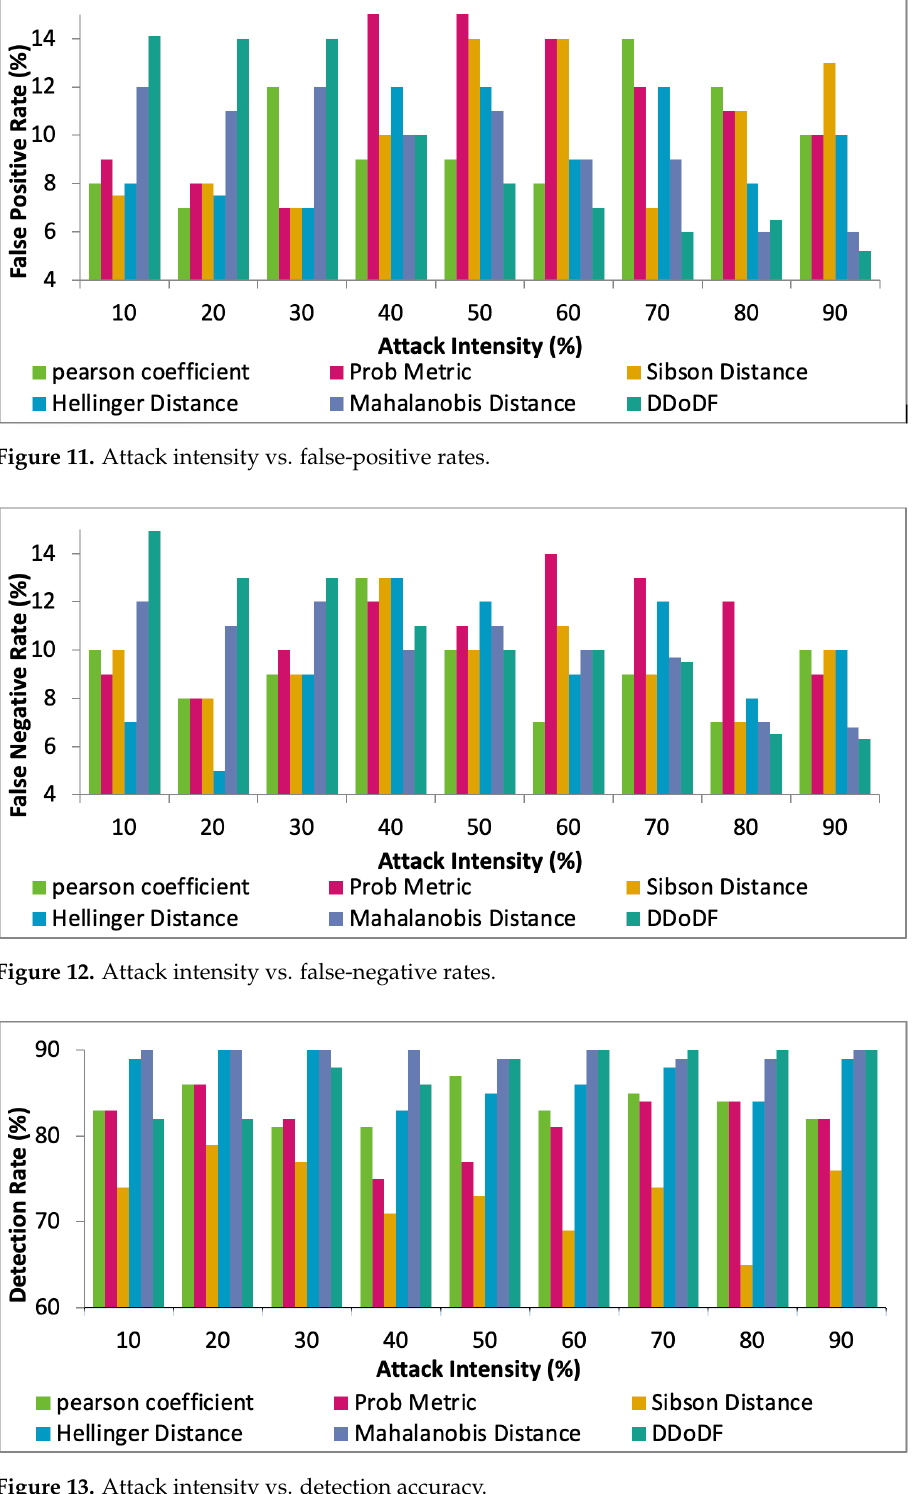
Figure 13. Attack intensity vs. detection